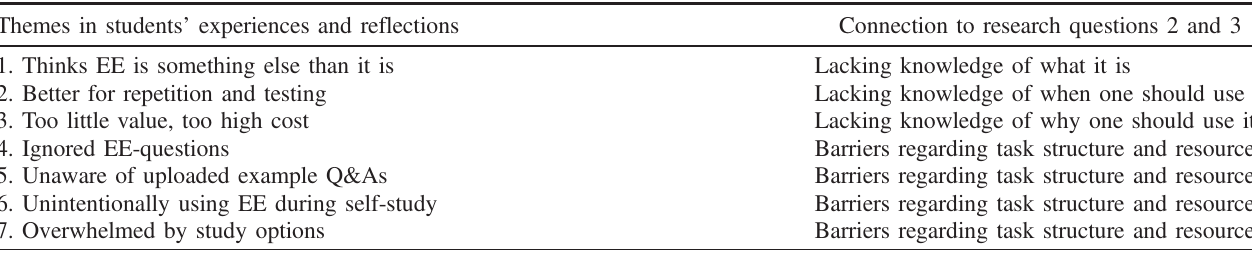
TABLE I. Themes from students ’ experiences and reflections on elaborative encoding (EE). Themes in students ’ experiences and